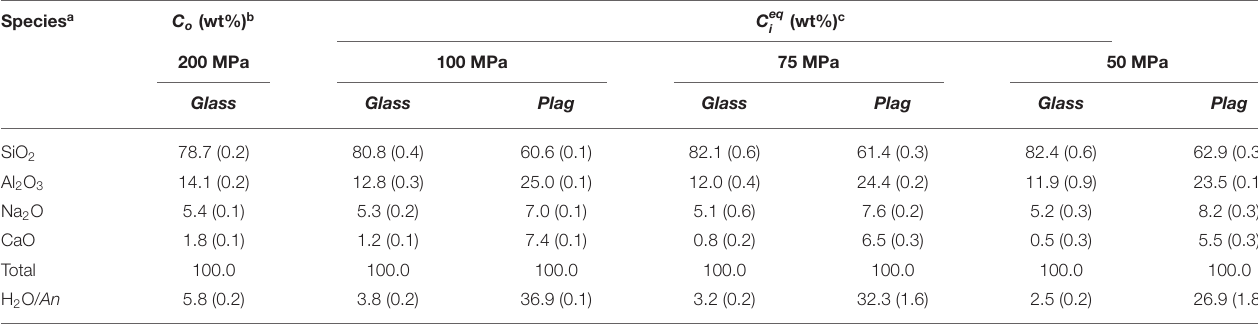
TABLE 5 | Initial and equilibrium compositions of the experimental glasses and plagioclases, from Mollard et al. (2012). Species